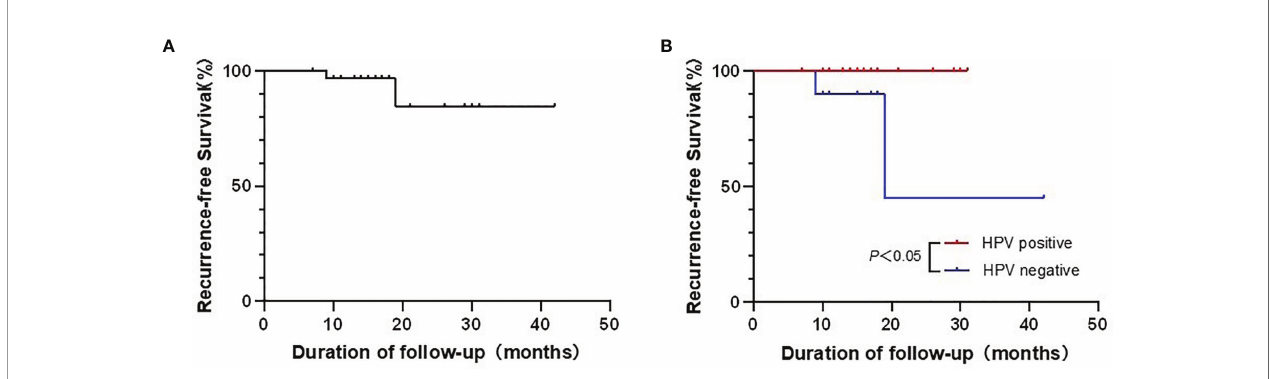
FIGURE 4 | (A) The recurrence-free survival (RFS) of this new approach in 31 patients. (B) The comparison of RFS between the HPV-positive group and HPV- negative